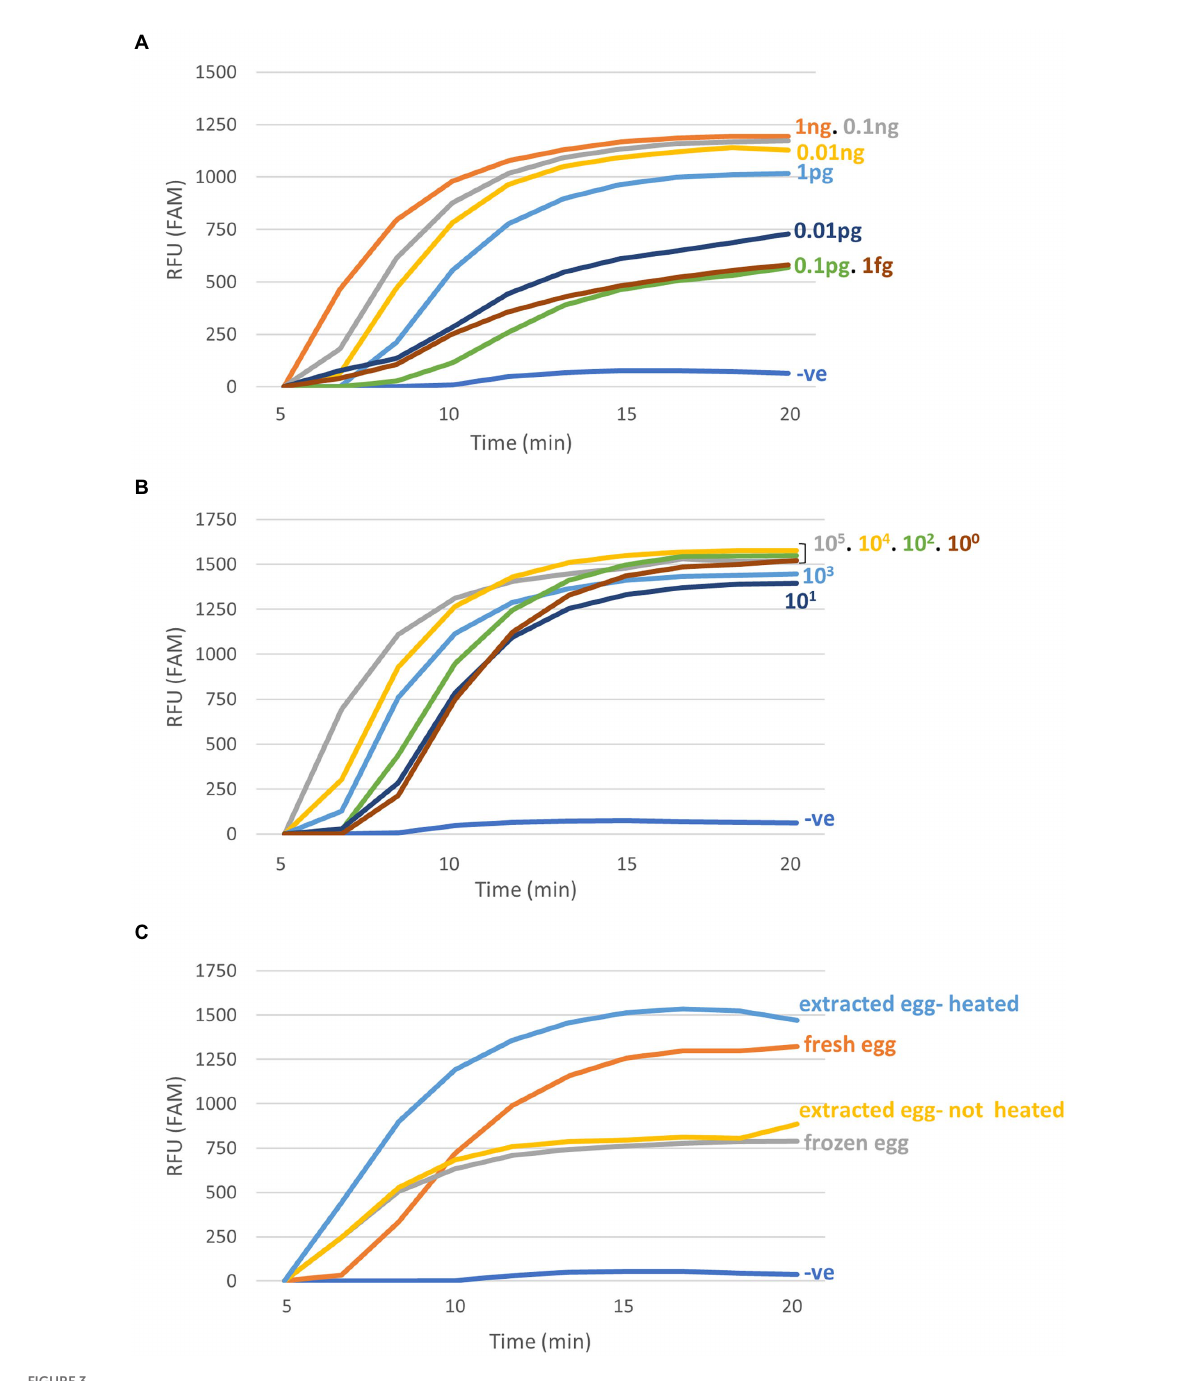
FIGURE 3 Limit of detection of the SmMIT-RPA. The assay was able to detect down to (A) 1 fg of the gDNA; (B) One synthetic copy of the target; (C) Single eggs extracted with the SwiftX ™ DNA kit with or without the heating step, and single crude eggs, collected fresh and frozen (no DNA extraction procedure used). All graphs are displayed with the background baseline fluorescence subtracted. Legend: RFU-relative fluorescence units; ng- nanogram; pg-picogram, fg-femtogram; − ve-negative control